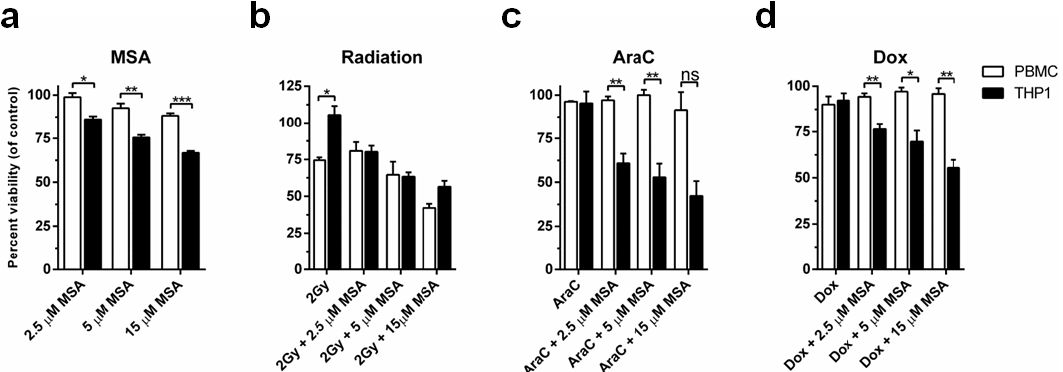
Figure 5. MSA protects normal cells and results in elevated cell killing of malignant cells after 48 h. ( a ) MSA treatment alone significantly reduces cell viability of malignant THP1 cells compared to